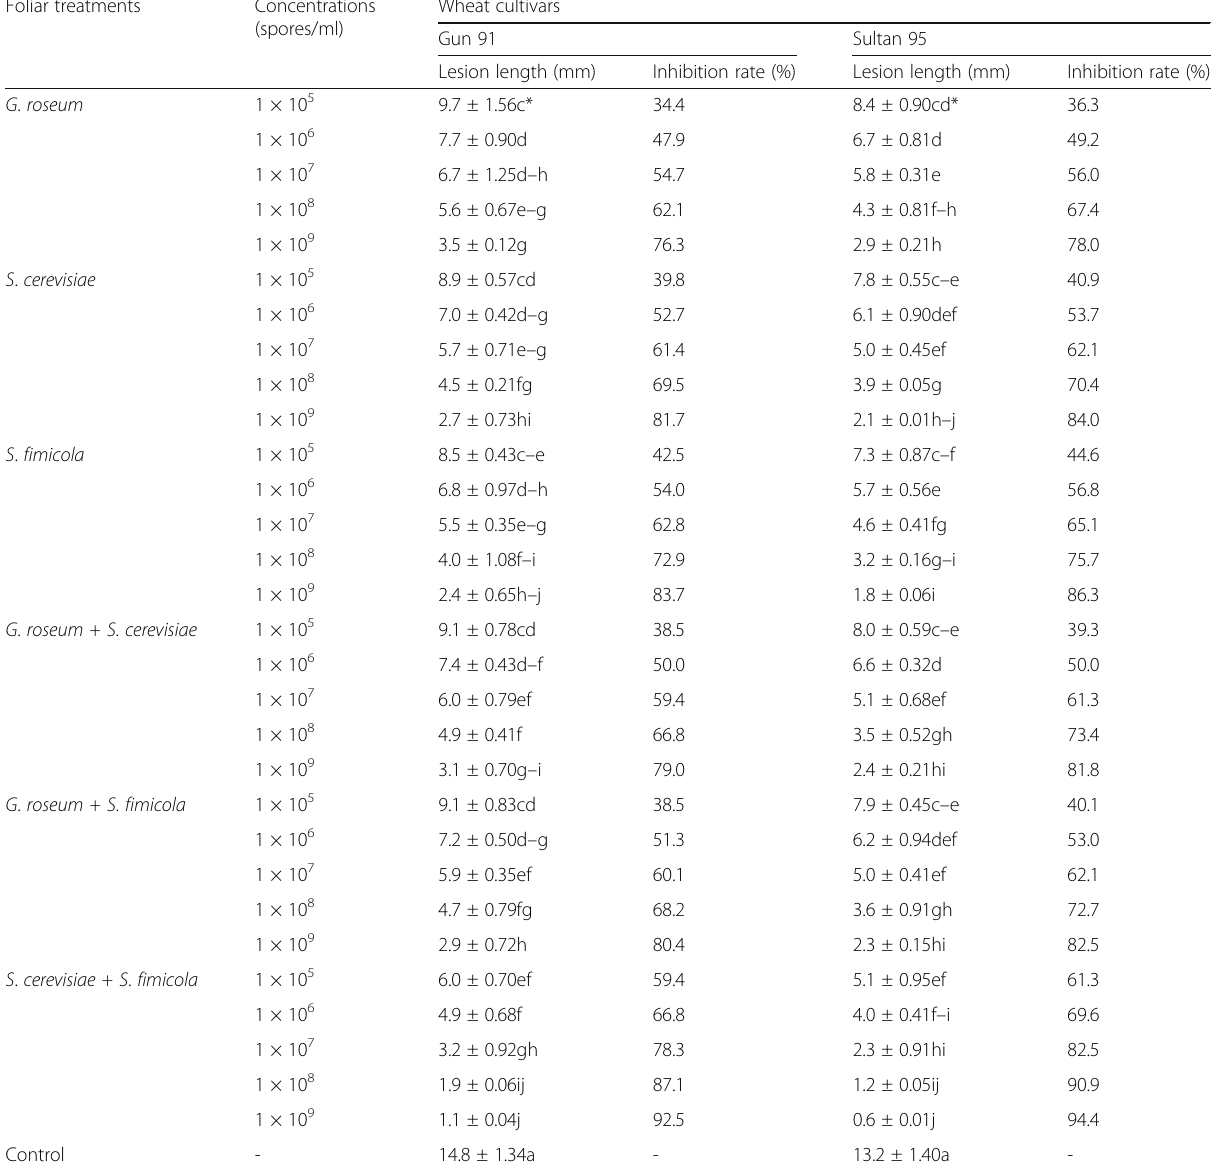
Table 2 Effect of different concentrations of the foliar treatments on lesion length caused by F . graminearum in wheat cultivars Foliar